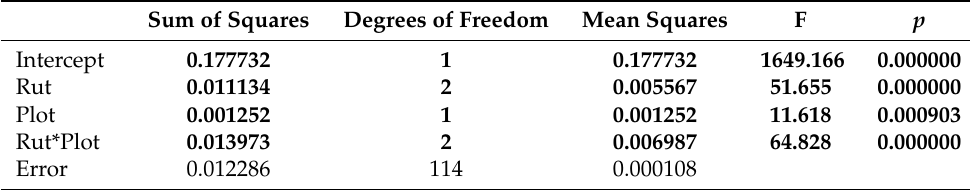
Figure 6. Depths of upper vs. lower ruts after the 40th pass at individual plots, where: x—mean; horizontal line—median; vertical lines depict 1st and 4th quartiles; boxes contain 2nd and 3rd quantiles divided by median lines. Table 7. ANOVA analysis of the rut depth (m), plot, and the rut type (upper vs. lower). Bold indicates statistical significance.